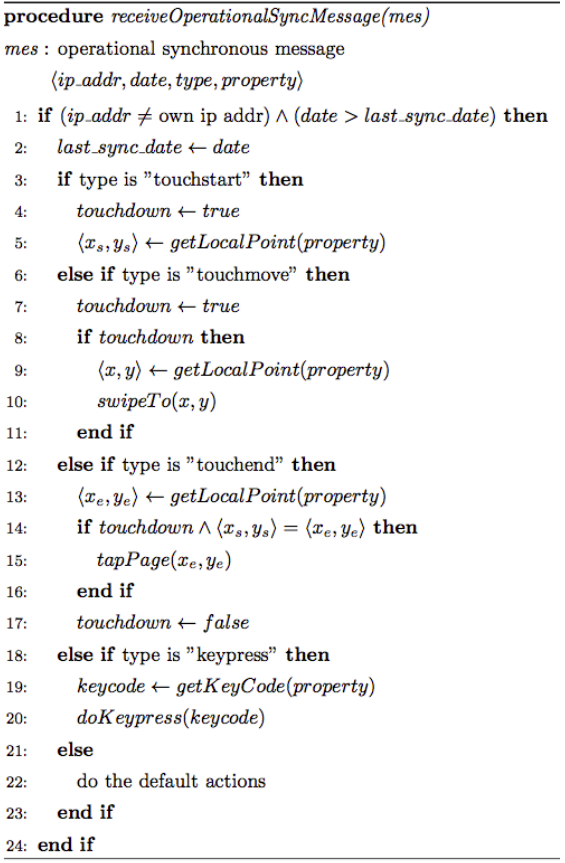
Fig. 7. The procedure that is called when the system